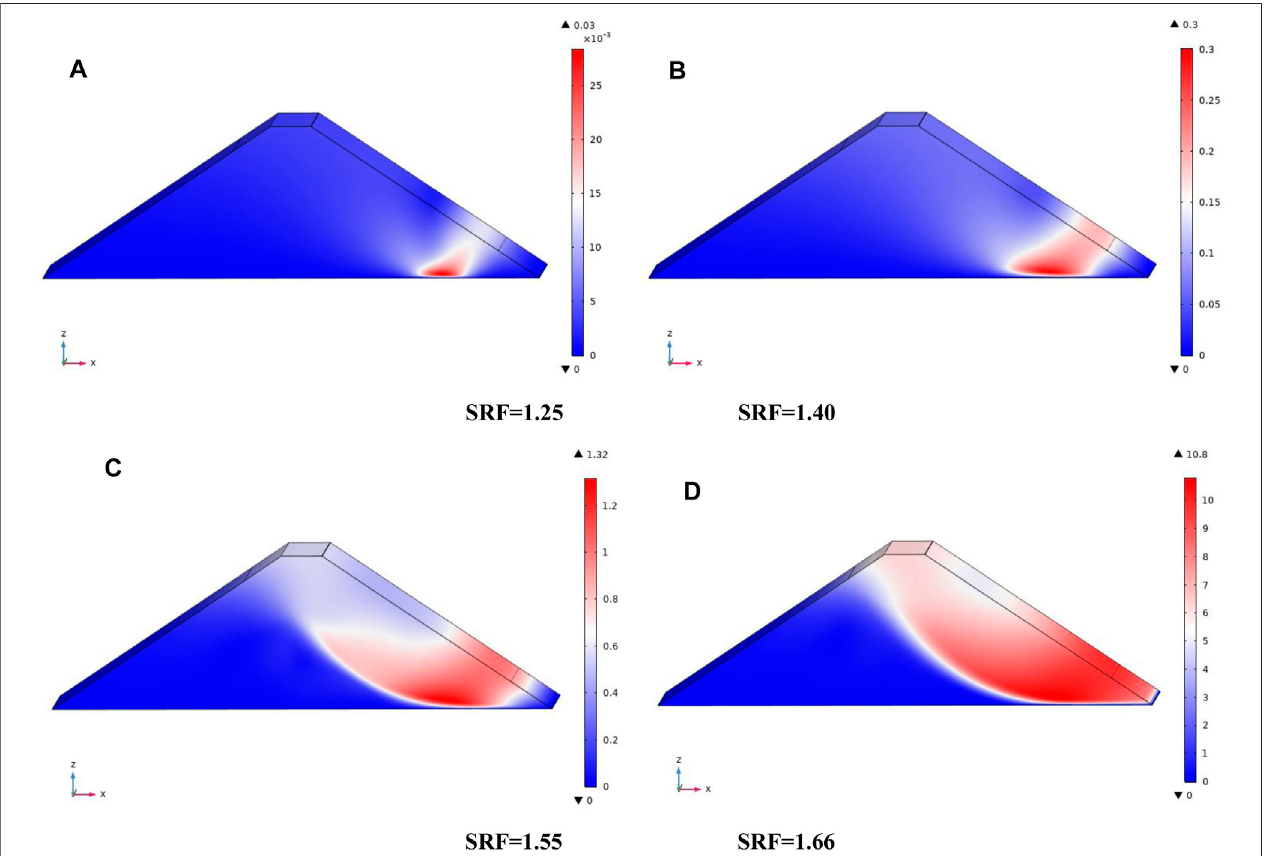
FIGURE 12 | Spatial distribution of displacement (in mm) in the dam slope under different SRFs. (A) SRF = 1.25, (B) SRF = 1.40, (C) SRF = 1.55, and (D) SRF = 1.66.